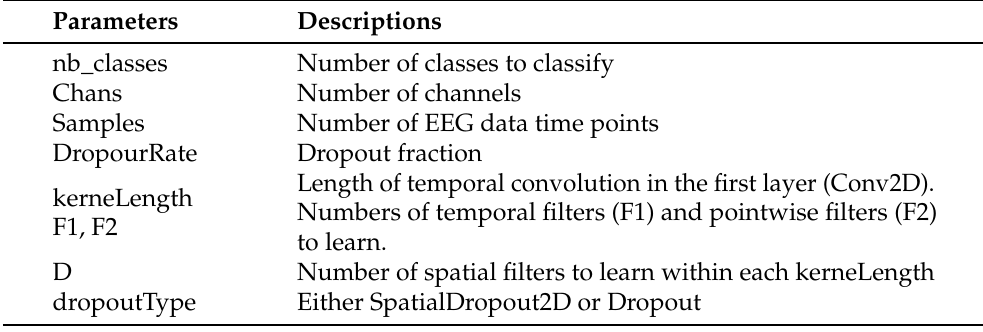
Table 5. Configurable input parameters of the EEGNet network, modified from